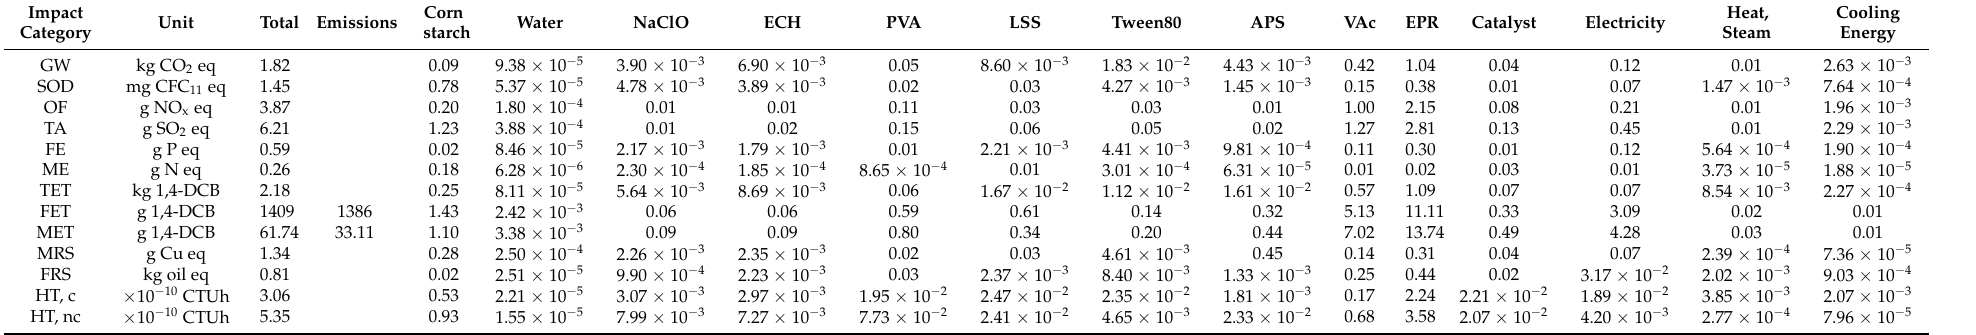
Table 9. Environmental characterization of starch bioadhesive oxidized with NaClO and